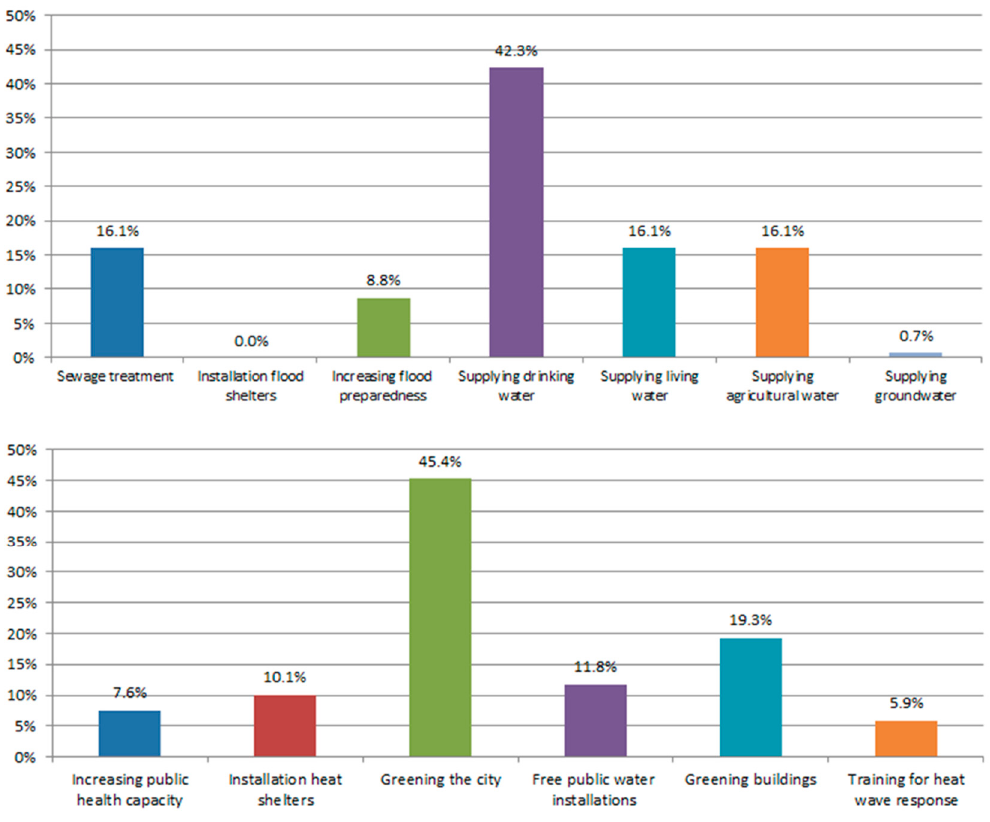
Figure 6. Most desirable climate change measures for the water ( top ) and heat ( bottom ) sectors as assessed by stakeholders.